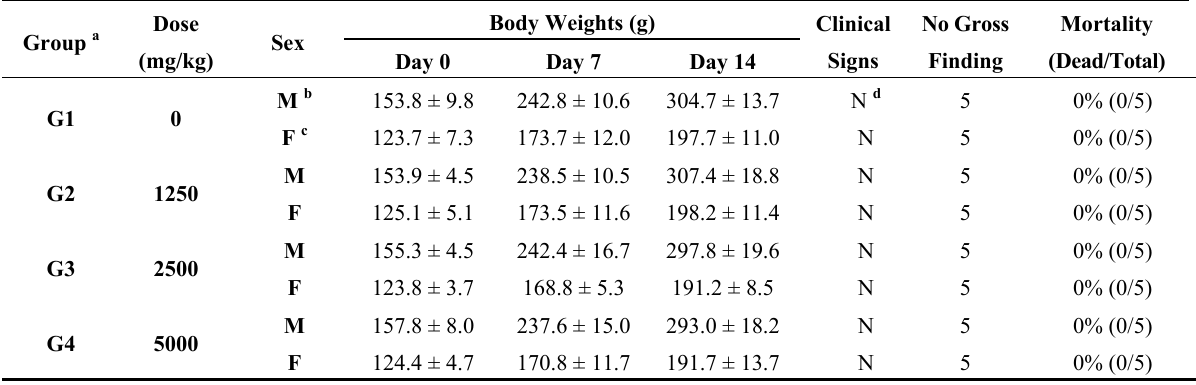
Body Weights (g) Clinical